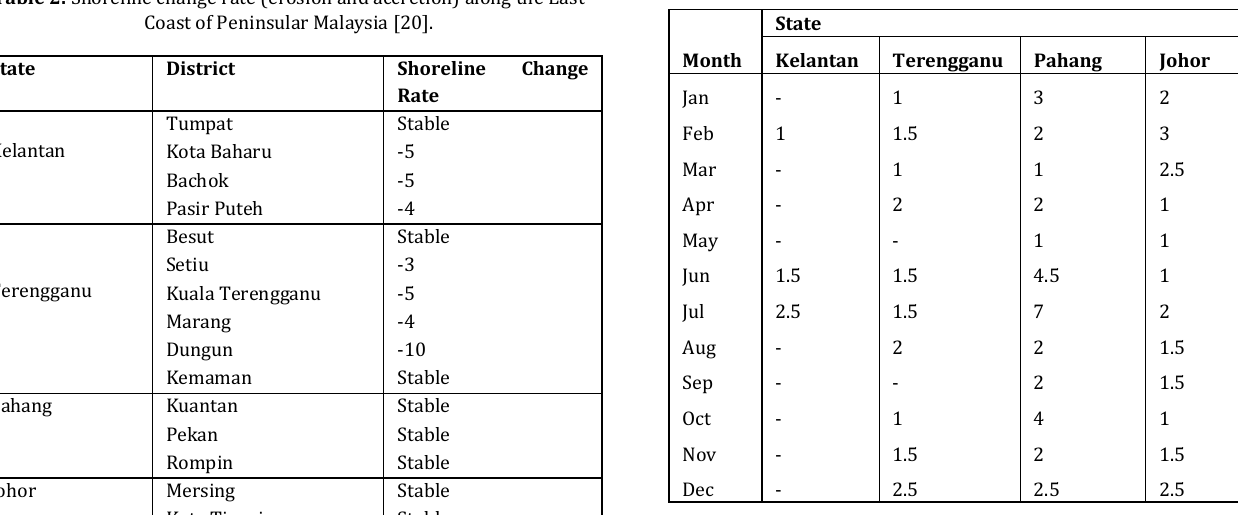
Table 4: Wave height along the East Coast of Peninsular Malaysia